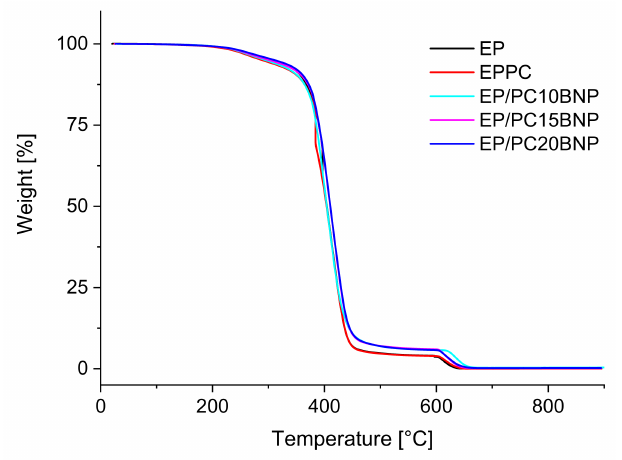
Figure A7. Thermogravimetric analysis on the epoxy, epoxy/polycarbonate, and epoxy/polycar- bonate/BNP